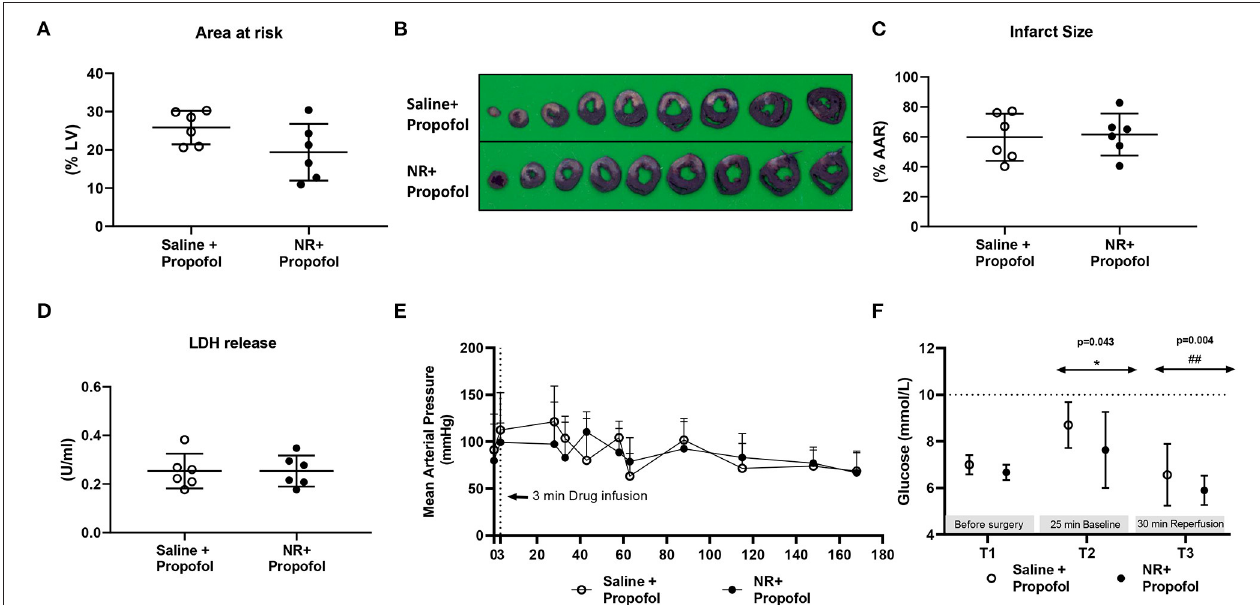
FIGURE 6 | NR lost protection against in vivo cardiac IR injury in presence of propofol. NR treatment failed to reduce infarction in the presence of propofol, a common clinically used anesthesia. (A) Area at risk (AAR) related to left ventricle area (LV); (B) Image of TTC staining; (C) Infarct size related to AAR; (D) LDH release; (E) Mean arterial pressure (mmHg) throughout the whole protocol; (F) glucose level at three time point. Data was analyzed by Student’s t -test; * P < 0.05 vs. T1, ## P < 0.01 vs. T2, MAP and glucose level were analyzed using two-way Repeated Measures ANOVA applying the Bonferroni multiple comparisons test when relevant. Saline group ( n = 6); NR group ( n =